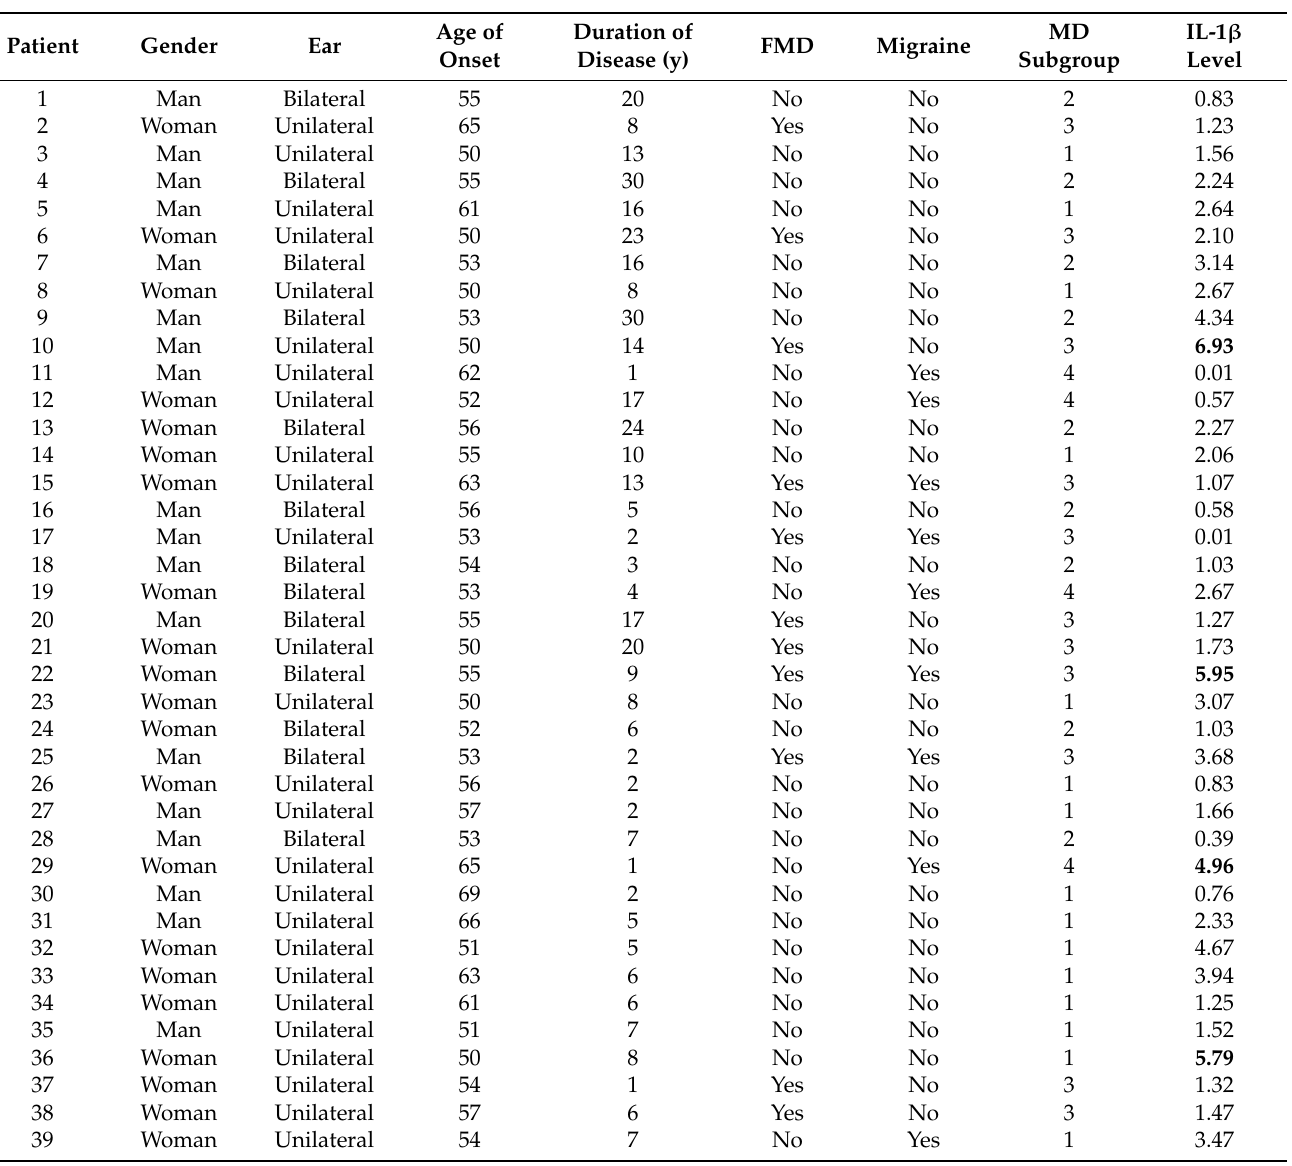
Table 3. Clinical features and basal levels of IL-1 β cytokine in patients with LOMD ( n = 39). Elevated levels of IL-1 β are highlighted in bold